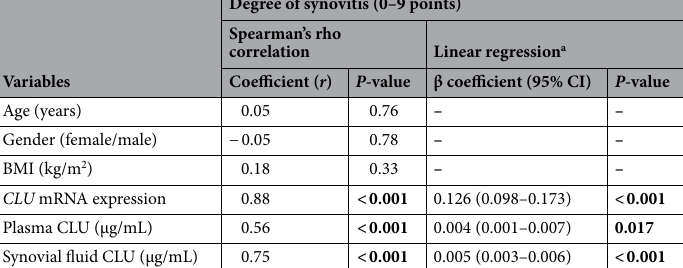
Table 1. Spearman’s correlation and multivariate linear regression analysis of synovitis severity estimates. BMI body mass index, CLU clusterin. Significant values are in bold. a The coefficient was adjusted for age, gender, and